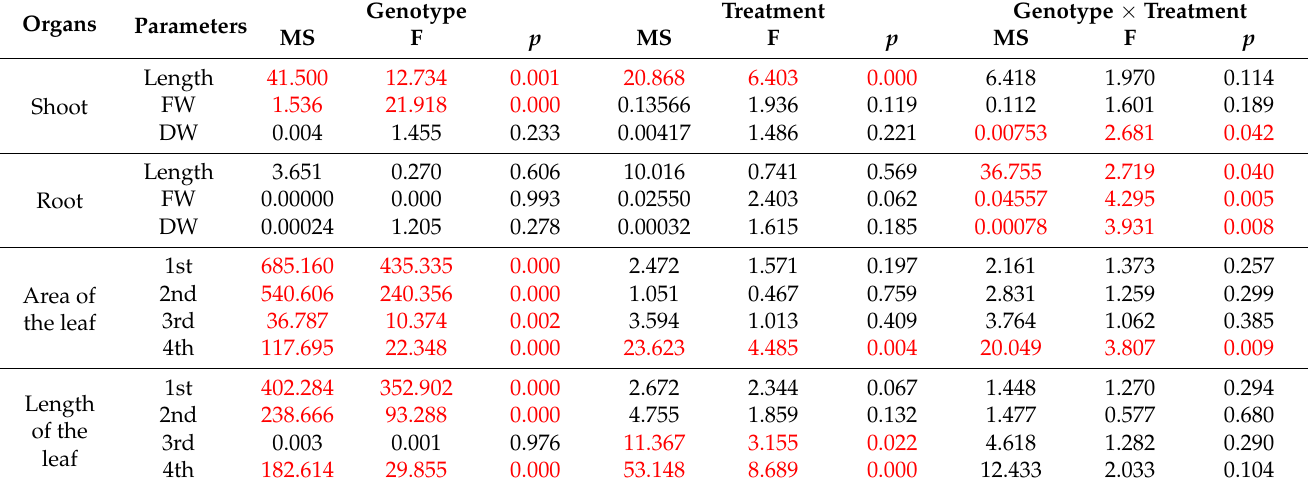
Table 2. Results of two-way ANOVA for two barley genotypes (Golden Promise and Haruna Nijo) grown under salt stress (150 mM sodium chloride) after bikinin treatment (non-treated; treated with 0.11% DMSO; and treated with 10 µ M, 50 µ M, and 100 µ M bikinin dissolved in 0.11% DMSO) were calculated for aboveground and belowground organ traits (length; FW, fresh weight; DW, dry weight;